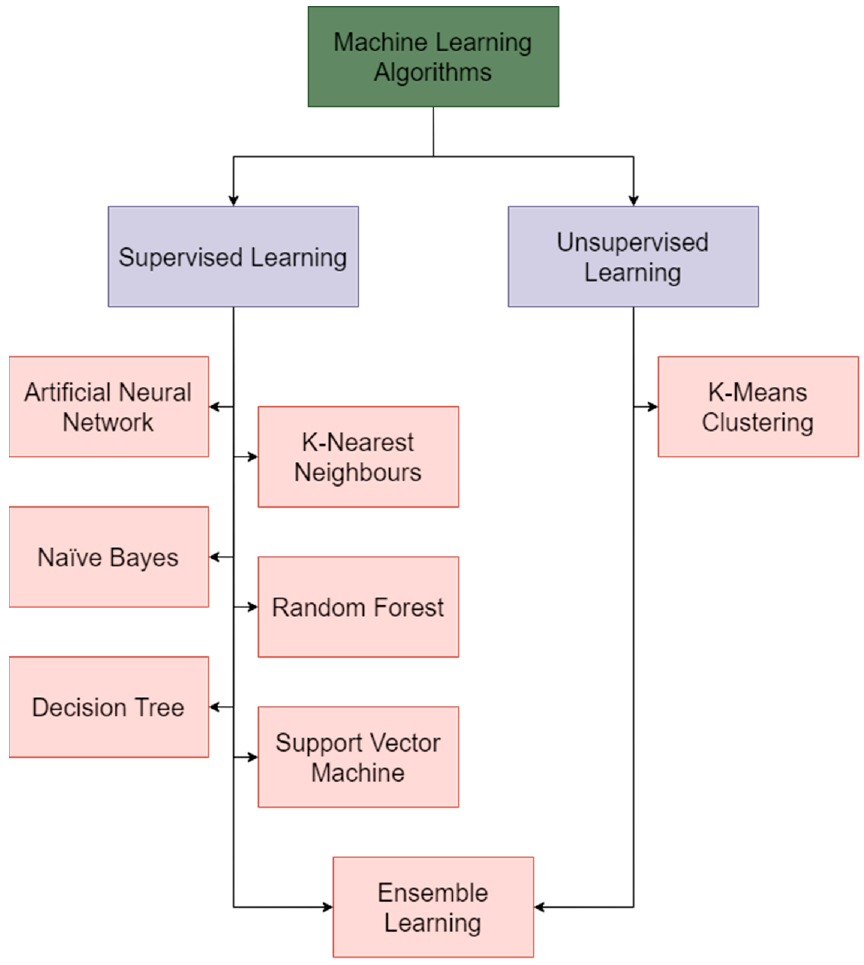
Figure 7. Current machine learning models in skin cancer diagnosis: tree illustration.